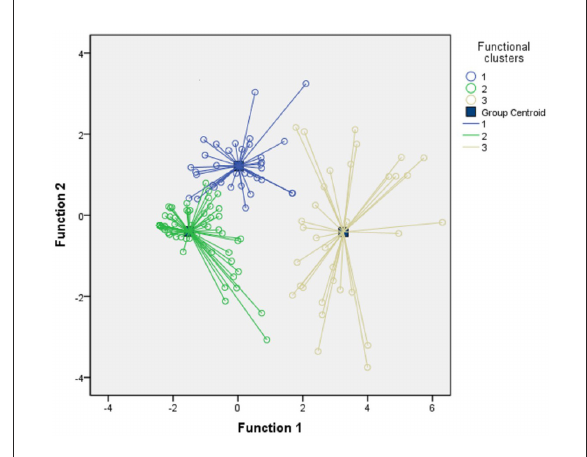
FIGURE1 Graphical agglomeration of functional subgroups in patients with BD. Scatter-plot and centroids of the discriminant values vie the discriminant functional analysis (DFA) based on the functional subgroups established from the hierarchical cluster analysis. The centroids are the mean score of three different clusters. Cluster 1 is the moderate functioning group (1 = MF), cluster 2 is the good functioning subgroup (2 = GF) and cluster 3 is the lower functioning group (3 =